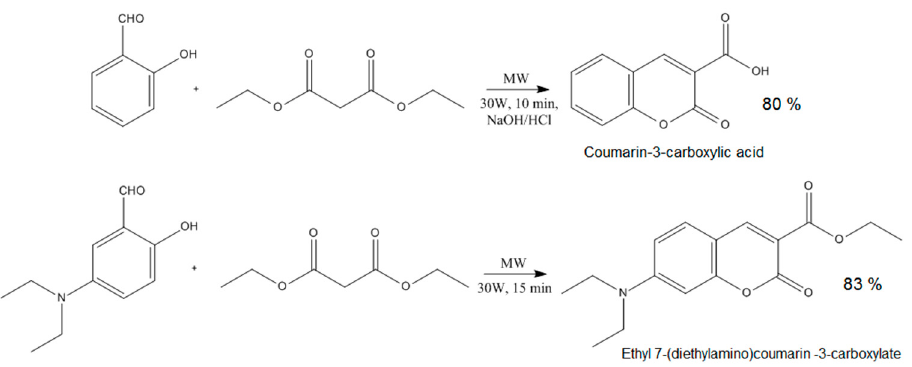
Figure 2. Coumarin derivatives’ synthesis Figure 2 . Coumarin derivatives’ synthesis pathway . Figure 2 . Coumarin derivatives’ synthesis pathway .